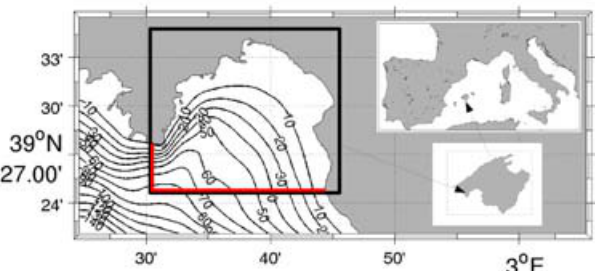
Fig. 1. Bathymetry contours (in meters) of the model domain. The black box indicates the Bay of Palma and the inset graphics give the geographical location of Mallorca Island in the western Mediter- ranean